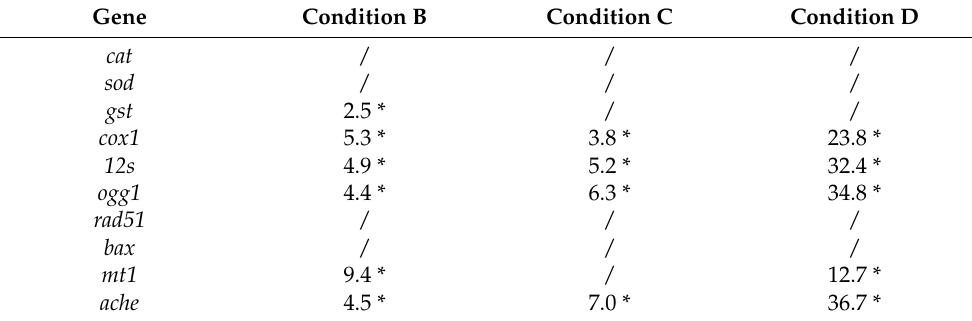
Table 4. Transcription levels of whole larvae of rainbow trout after 3 weeks of exposure to a mixture of copper, glyphosate and chlorpyrifos. Data was expressed as induction (above 2) or repression (below 0.5) factors compared to the control condition. Asterisks (*) refer to significant differences compared to control condition ( n = 3, ANOVA, p < 0.05). /: identical to control. Gene Condition B Condition C Condition D cat /